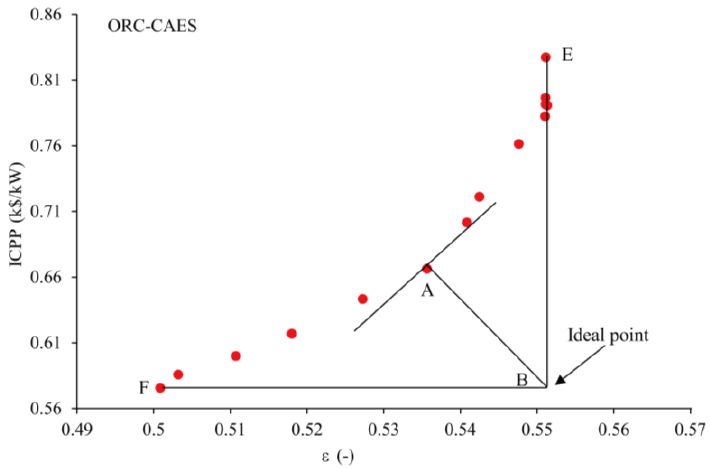
Figure 9. Pareto frontier of the ORC-CAES system for ICPP versus ε using multi-objective GA.